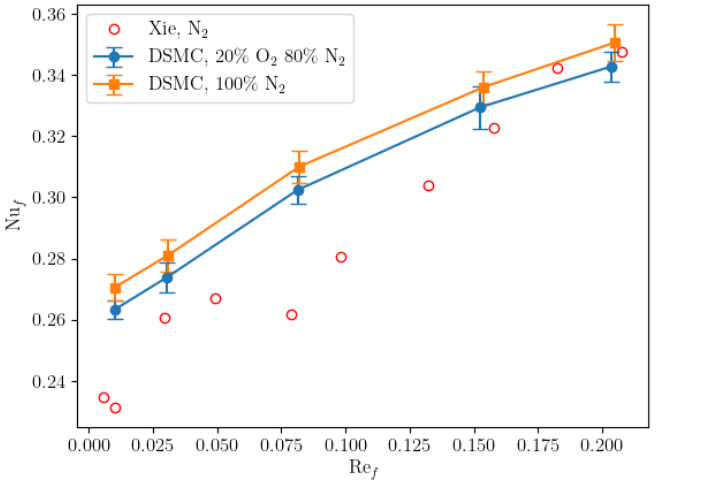
Figure 7. Comparison of DSMC simulation results using two different gas mixtures and experimental data [6]. Error bars indicate ± 1 σ of the steady-state DSMC